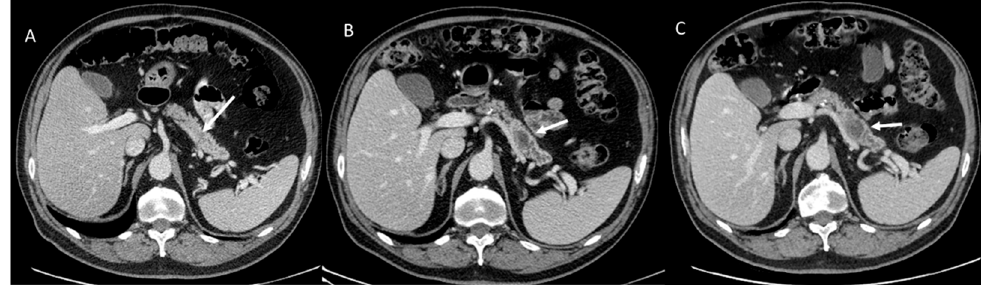
Figure 1. CT evaluation in melanoma patient with FAMM. In ( A ), arrow shows non-detectable lesion. In ( B ) arrow shows PDAC after 1 years (respect to CT assessment of ( A )) and in ( C ) after 3 months (respect to CT assessment of ( B )).